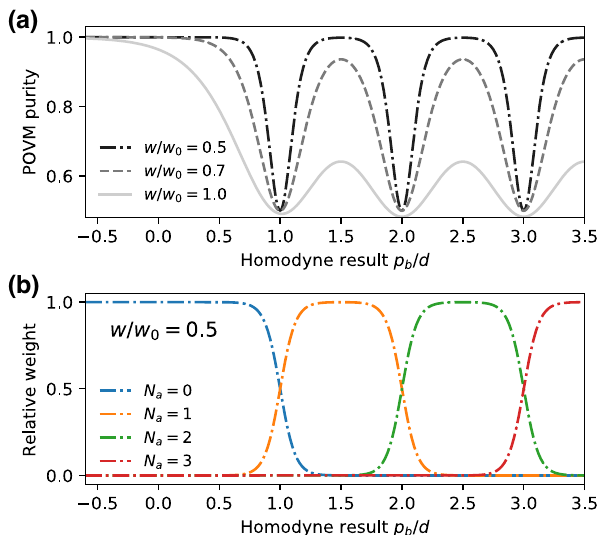
FIG. 2. (a) Purity of the POVM for our QND measurement protocol [62] as a function of the pump homodyne outcome p b . We consider a Gaussian probe pump state | ϕ b ( 0 ) (cid:5) with various widths w , where w below the vacuum level w 0 = 1 / 2 indi- cates that | ϕ b ( 0 ) (cid:5) is a squeezed vacuum. (b) Relative weights of ( p ) in the POVM as a func- squeezed-Fock-state projector W N b a tion of p b for w / w 0 = 0.5. We assume conditional displacement of d = ˜ gt = 1.0 for all